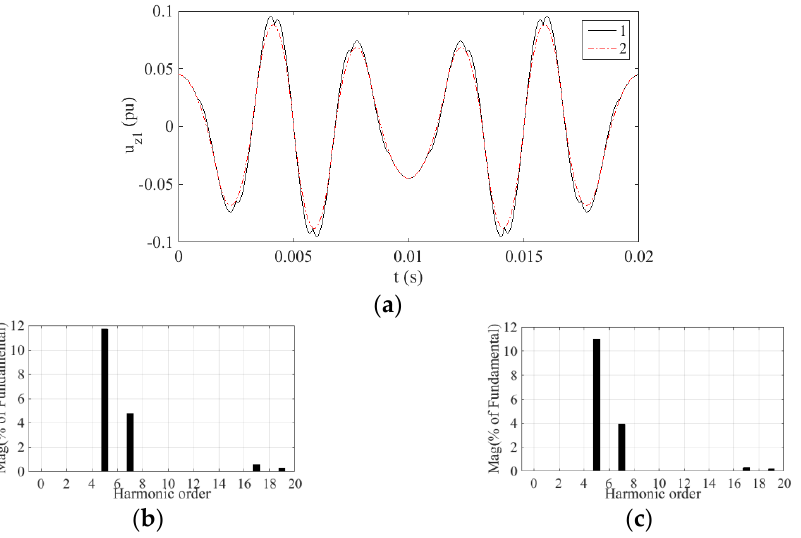
Figure 10. Simulation results u z1 of two strategies at m = 0.622. Here, 1 denotes the TFOS strategy, 2 denotes the proposed HSOS strategy: ( a ) u z1 waveforms of the two strategies; ( b ) Spectrum analysis of the TFOS; ( c ) Spectrum analysis of the proposed HSOS.